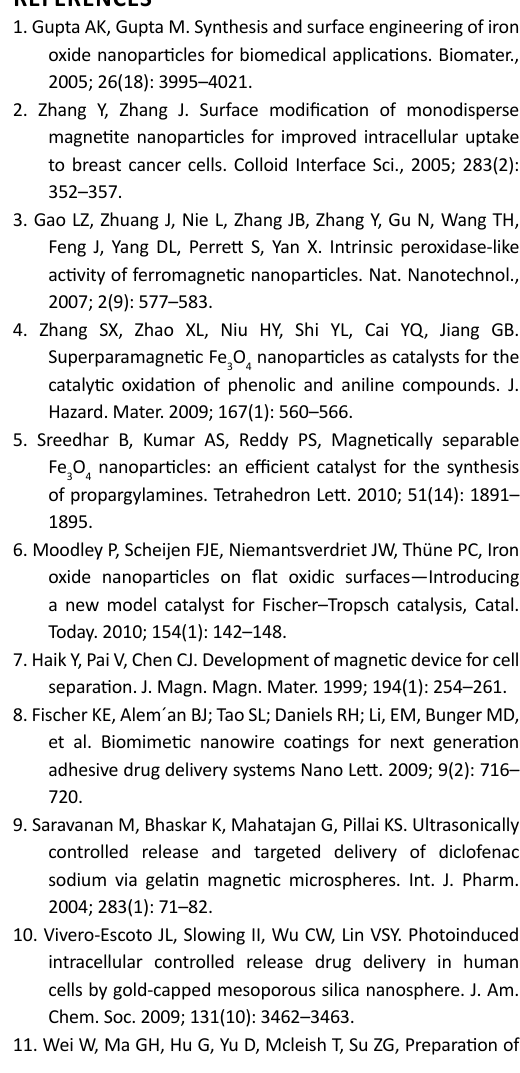
Fig. 8. Effect of phenylalanine concentrationon its removal by: (A) uncoated Fe nanosorbents and (C) CTAB-coated Fe change was observed after